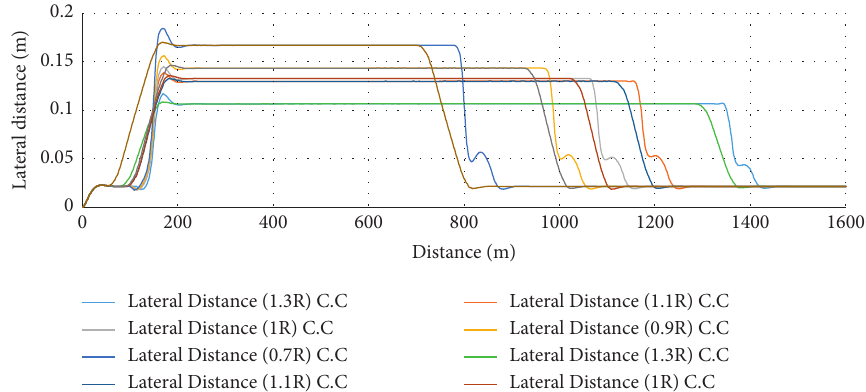
Figure 24: Lateral distance versus path length for various radii of simple and spiral horizontal curves; C.C is the simple horizontal curve, and C.S is the spiral horizontal curve.